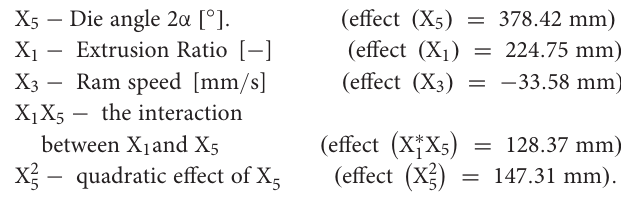
FIGURE 4 | Different modes of sleeve fracture; (A) multiple sleeve fractures, (B) single sleeve fracture, and (C) no sleeve fracture.